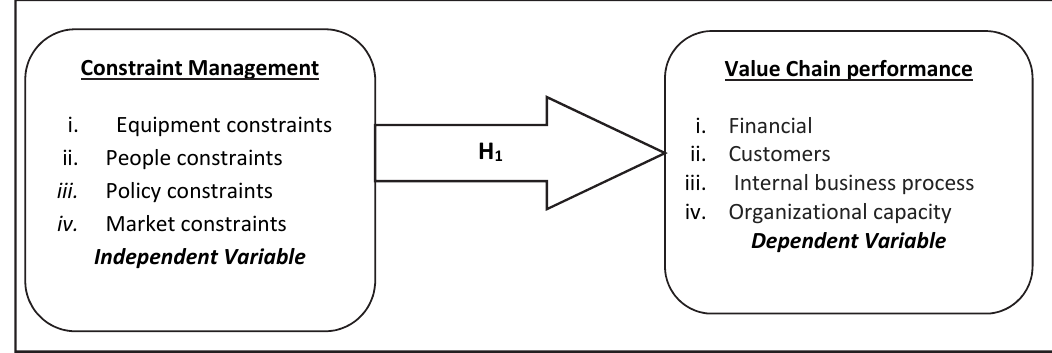
Fig. 1. A conceptual